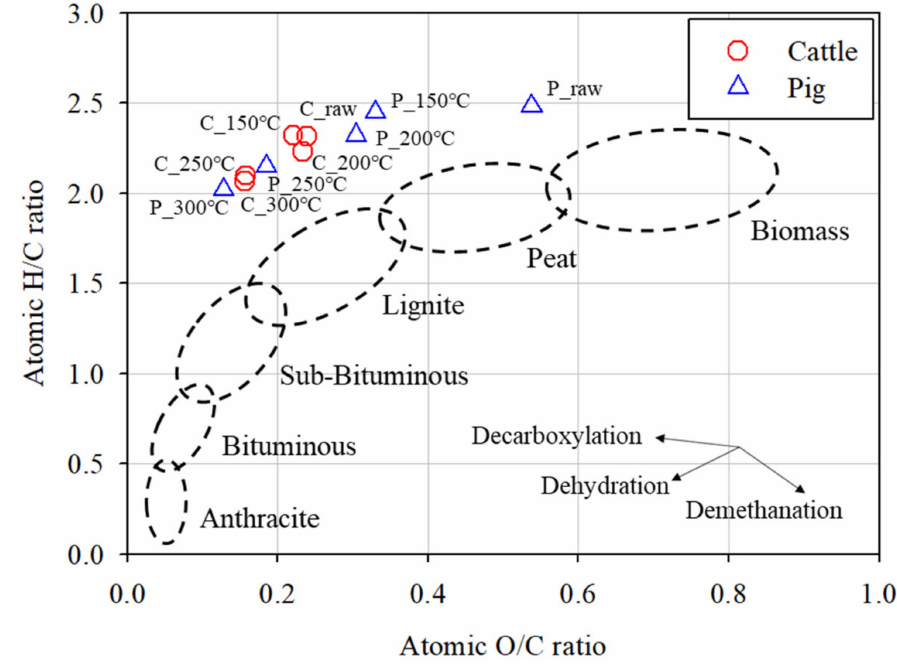
Figure 3. Van Krevelen diagram of the cattle and pig SHWs and